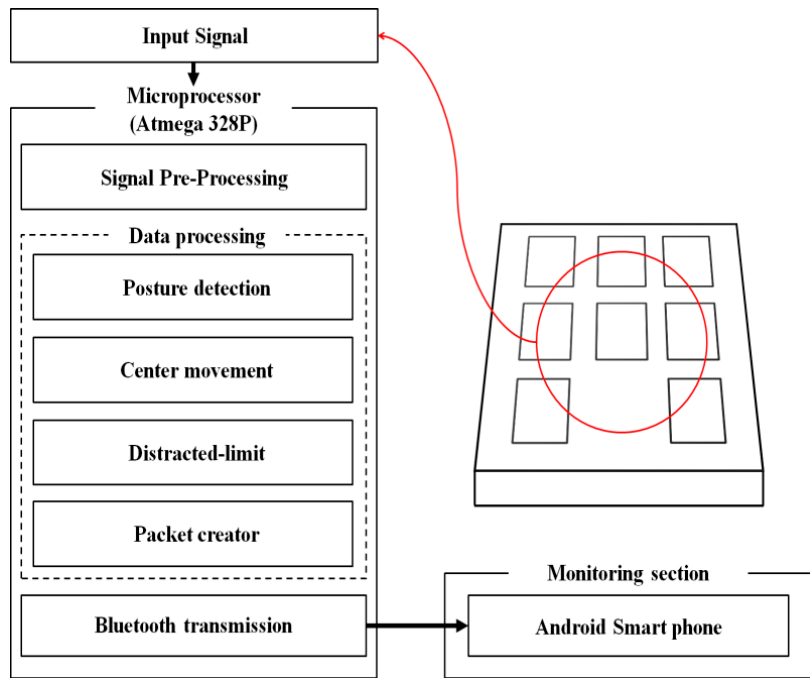
Figure 2. Control interface.